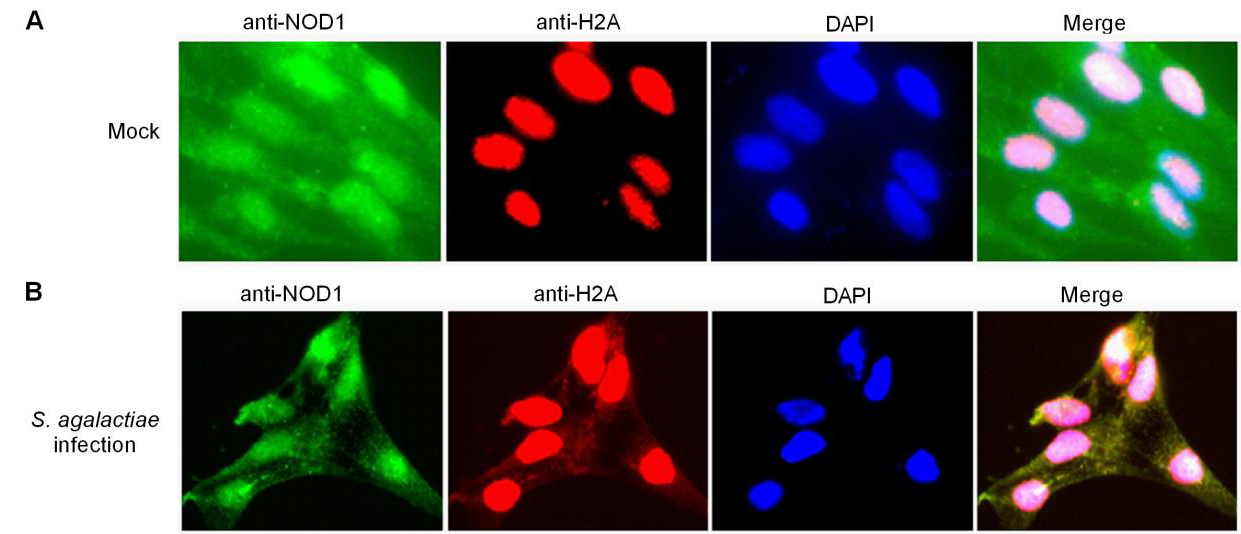
Figure 7. The colocalization between NOD1 and histone H2A in ZF4 cells. ( A ) The colocalization between NOD1 and histone H2A in mock-infected ZF4 cells. ( B ) The colocalization between NOD1 and histone H2A in the ZF4 cells infected with S. agalactiae .